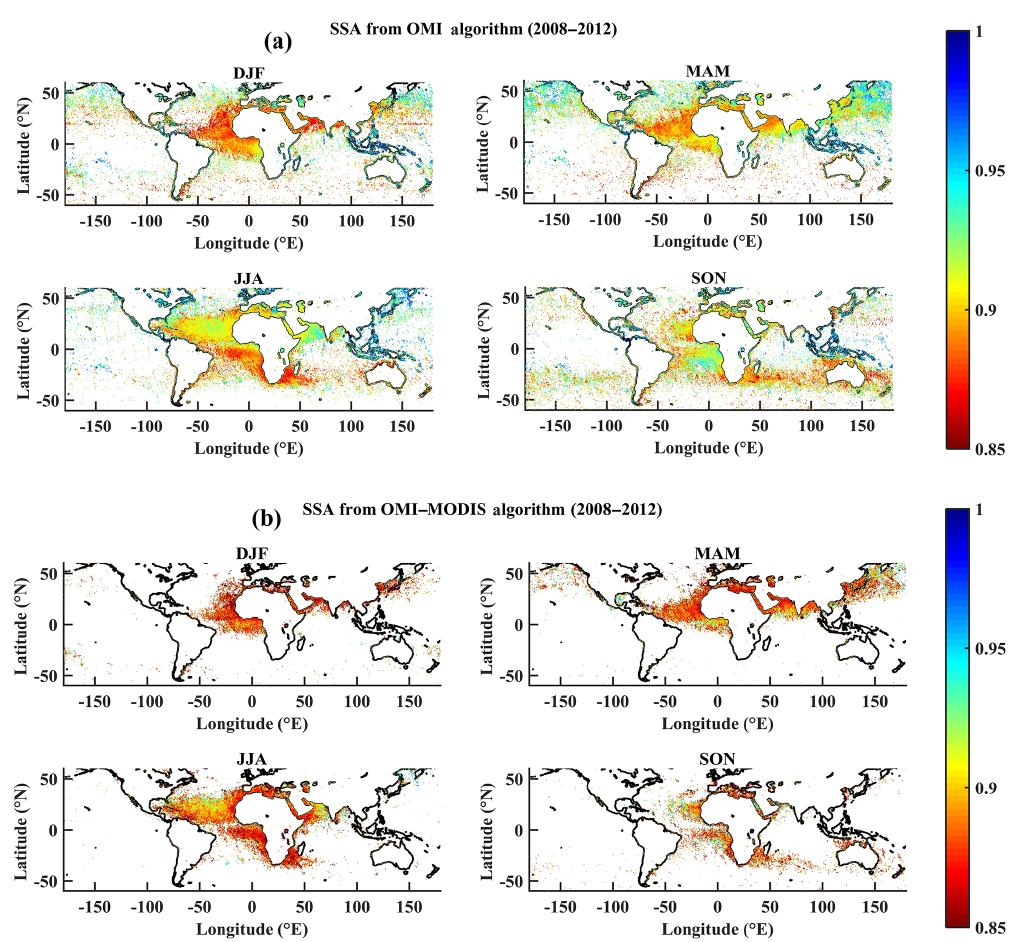
Figure 1. Spatial distribution of SSA at 388nm retrieved by (a) OMI and (b) OMI–MODIS. In the present study, points that had the same SSA value at the five discrete heights provided by OMI or an invalid value at any one height were considered invalid for the OMI–MODIS retrieval as interpolation was not possible. This resulted in a reduction of the number of valid points for OMI–MODIS compared with